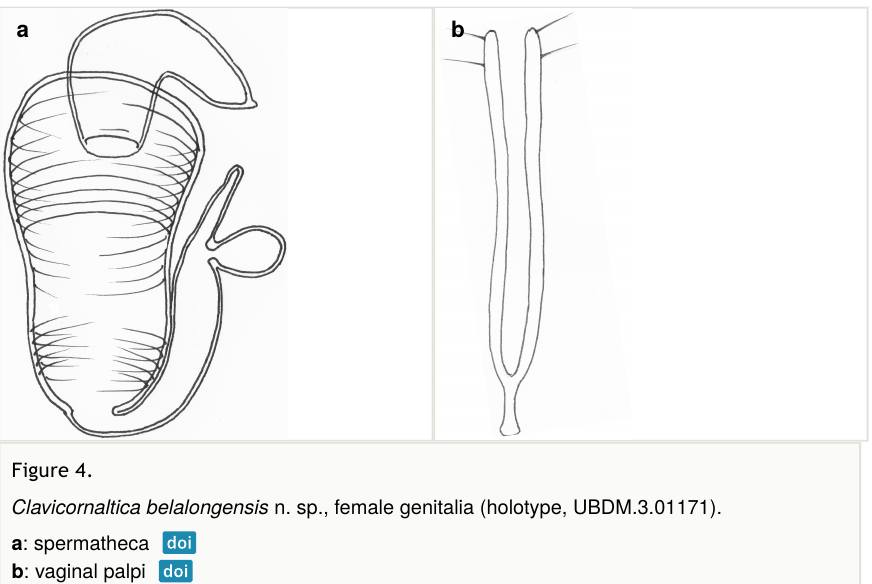
Figure 4. Clavicornaltica belalongensis n. sp., female genitalia (holotype,